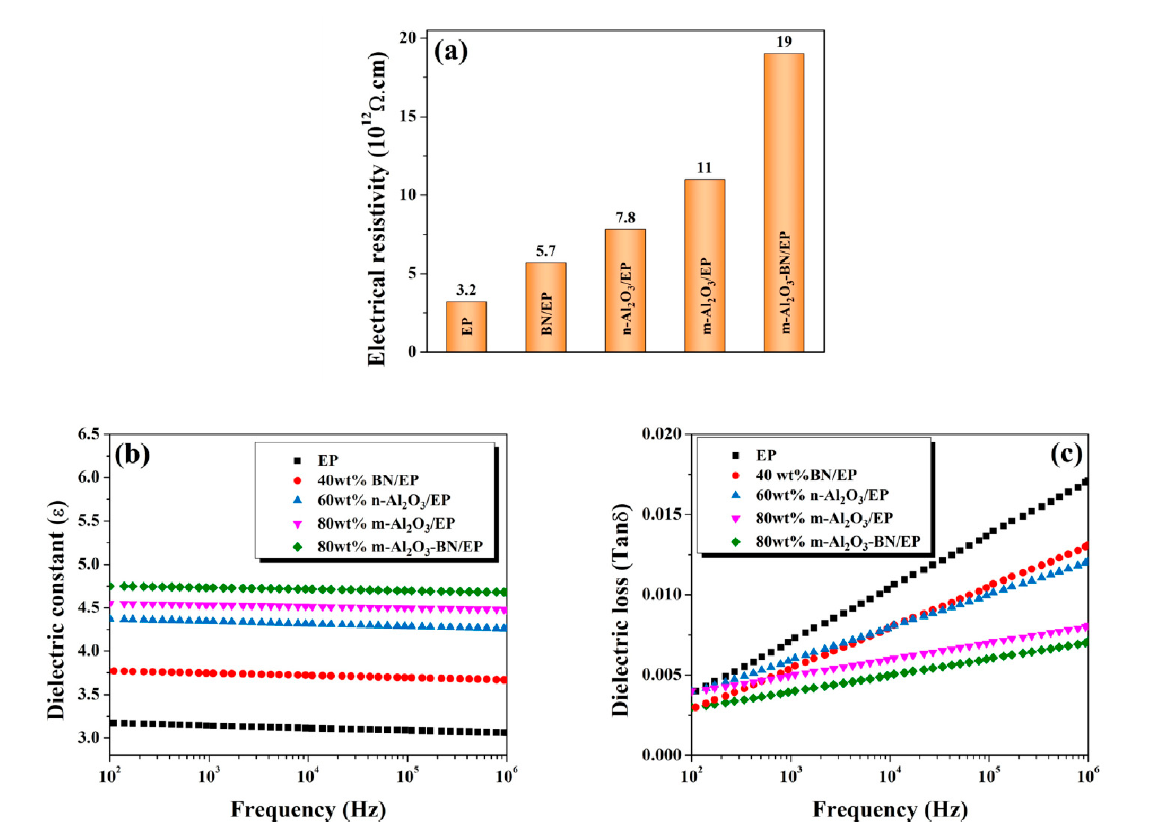
Figure 12. Electrical properties graphs of the different EP composites at maximum filler wt% achieved in this study: ( a ) Volume resistivity; ( b ) Dielectric constant versus frequency, and ( c ) Dielectric loss versus frequency.